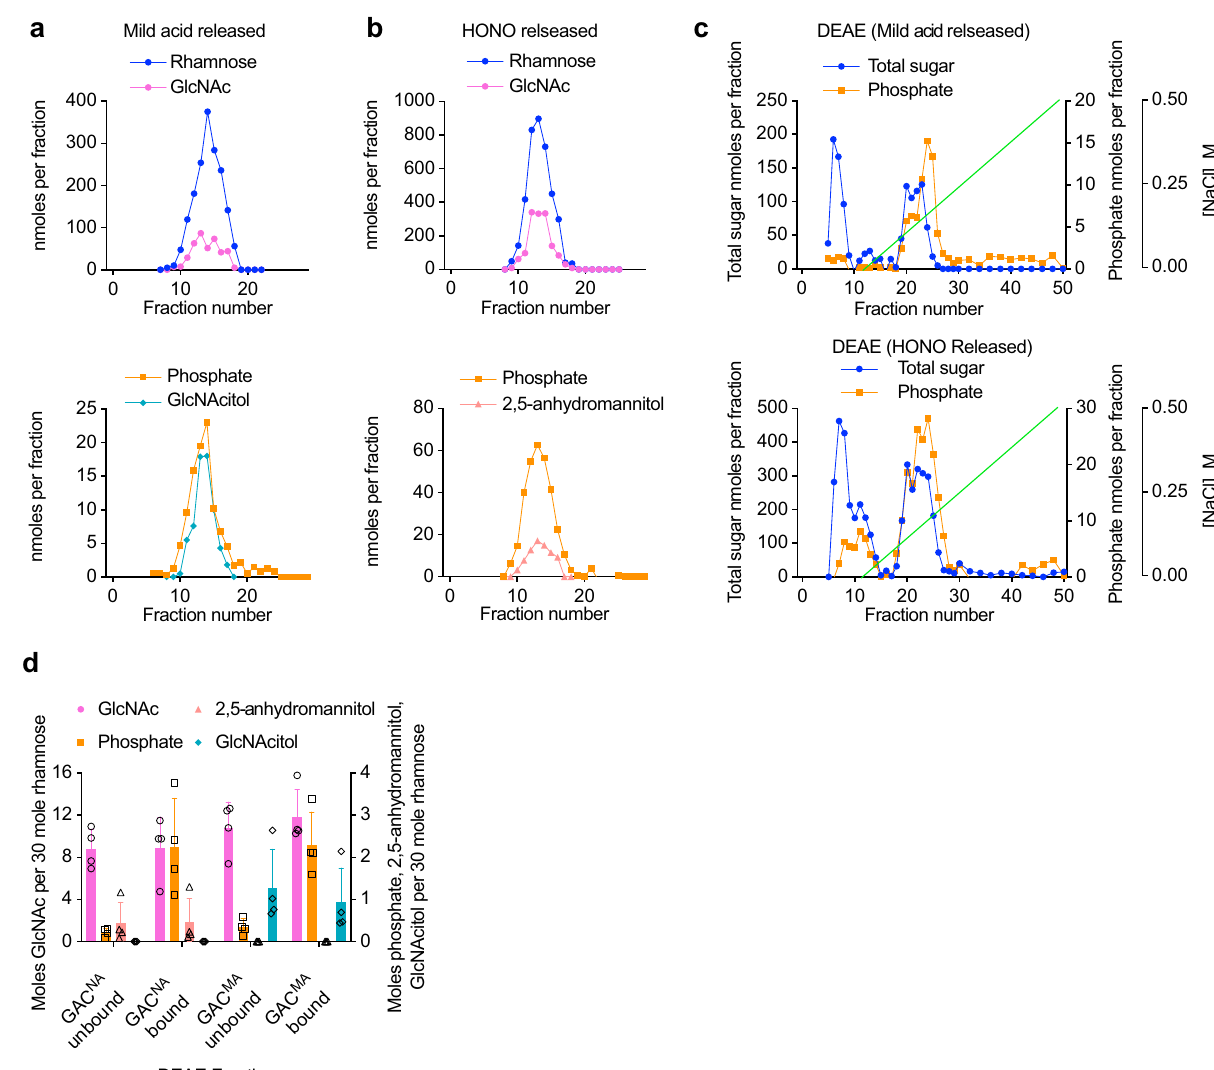
Fig. 2 Glycosyl composition analysis of GAC released from cell wall by the chemical treatments and puri fi ed by size-exclusion and ion-exchange chromatography. a Size-exclusion chromatography of GAC released from GAS cell wall by mild acid hydrolysis or b deamination with HONO. Upper and lower panels show the composition of the BioGel P150 fractions of the individual GAC preparations. Prior to the chromatography, the extracted GAC material was reduced chemically with sodium borohydride. Fractions were analyzed for phosphate content by malachite green assay following digestion with perchloric acid. Rha and GlcNAc contents were measured by GC-MS as TMS-methyl-glycosides. GlcNAcitol and 2,5-anhydromannitol contents were estimated by GC-MS as alditol acetates. The chromatographic pro fi les are representative of more than three separate experiments. c Ion-exchange chromatography of GAC released from the GAS cell wall by mild acid (upper panel) and HONO (lower panel). Fractions containing the GAC material from ( a , b ) were pooled, concentrated, desalted by spin column, loaded onto DEAE-Toyopearl and eluted with a NaCl gradient (0 – 0.5 M). Fractions were analyzed for total sugar content by anthrone assay and total phosphate content by malachite green assay following perchloric acid digestion. The experiments were performed at least three times and yielded the same results. Data from one representative experiment are shown. d Glycosyl composition analysis of the GAC material puri fi ed by ion-exchange chromatography. The GAC material released by either deamination with HONO (GAC NA ) or mild acid hydrolysis (GAC MA ) was analyzed as shown in ( c ). Fractions unbound ( fl ow-through) and bound (eluted with a NaCl gradient) to the DEAE column were pooled, concentrated, desalted by spin column and analyzed by GC-MS to determine the Rha, GlcNAc, 2,5-anhydromannitol and GlcNAcitol concentrations as described above. Malachite green assay was used to assay the phosphate concentration. The concentrations of GlcNAc, 2,5- anhydromannitol, GlcNAcitol and phosphate are expressed as moles per 30 moles of Rha. Columns and error bars represent the mean and S.D., respectively ( n = 4 biologically independent replicates). Source data are provided as a Source data fi